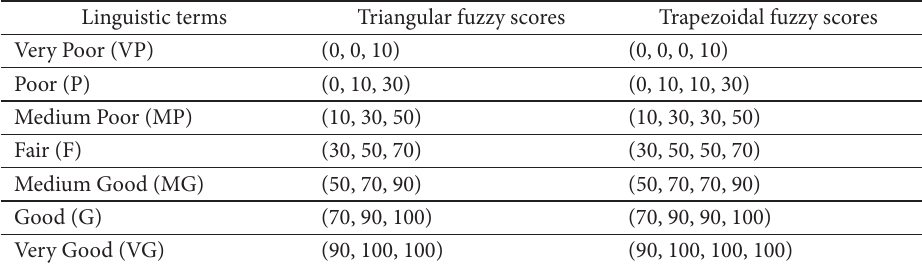
Table 2. Fuzzy evaluation scores for the alternatives Linguistic terms Triangular fuzzy scores Trapezoidal fuzzy